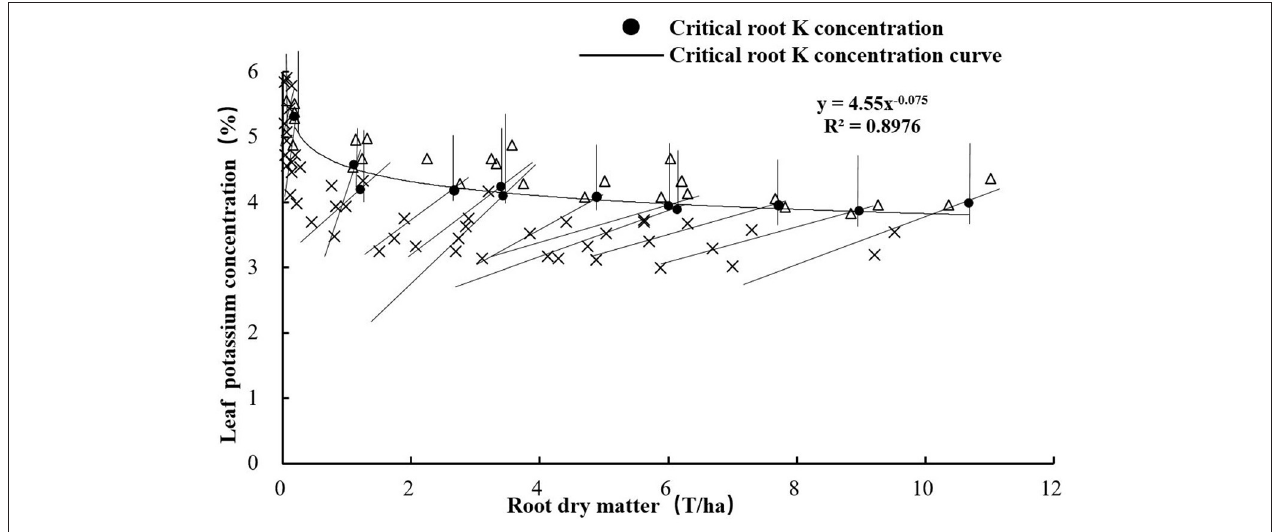
FIGURE 4 | Critical leaf K concentration curve based on